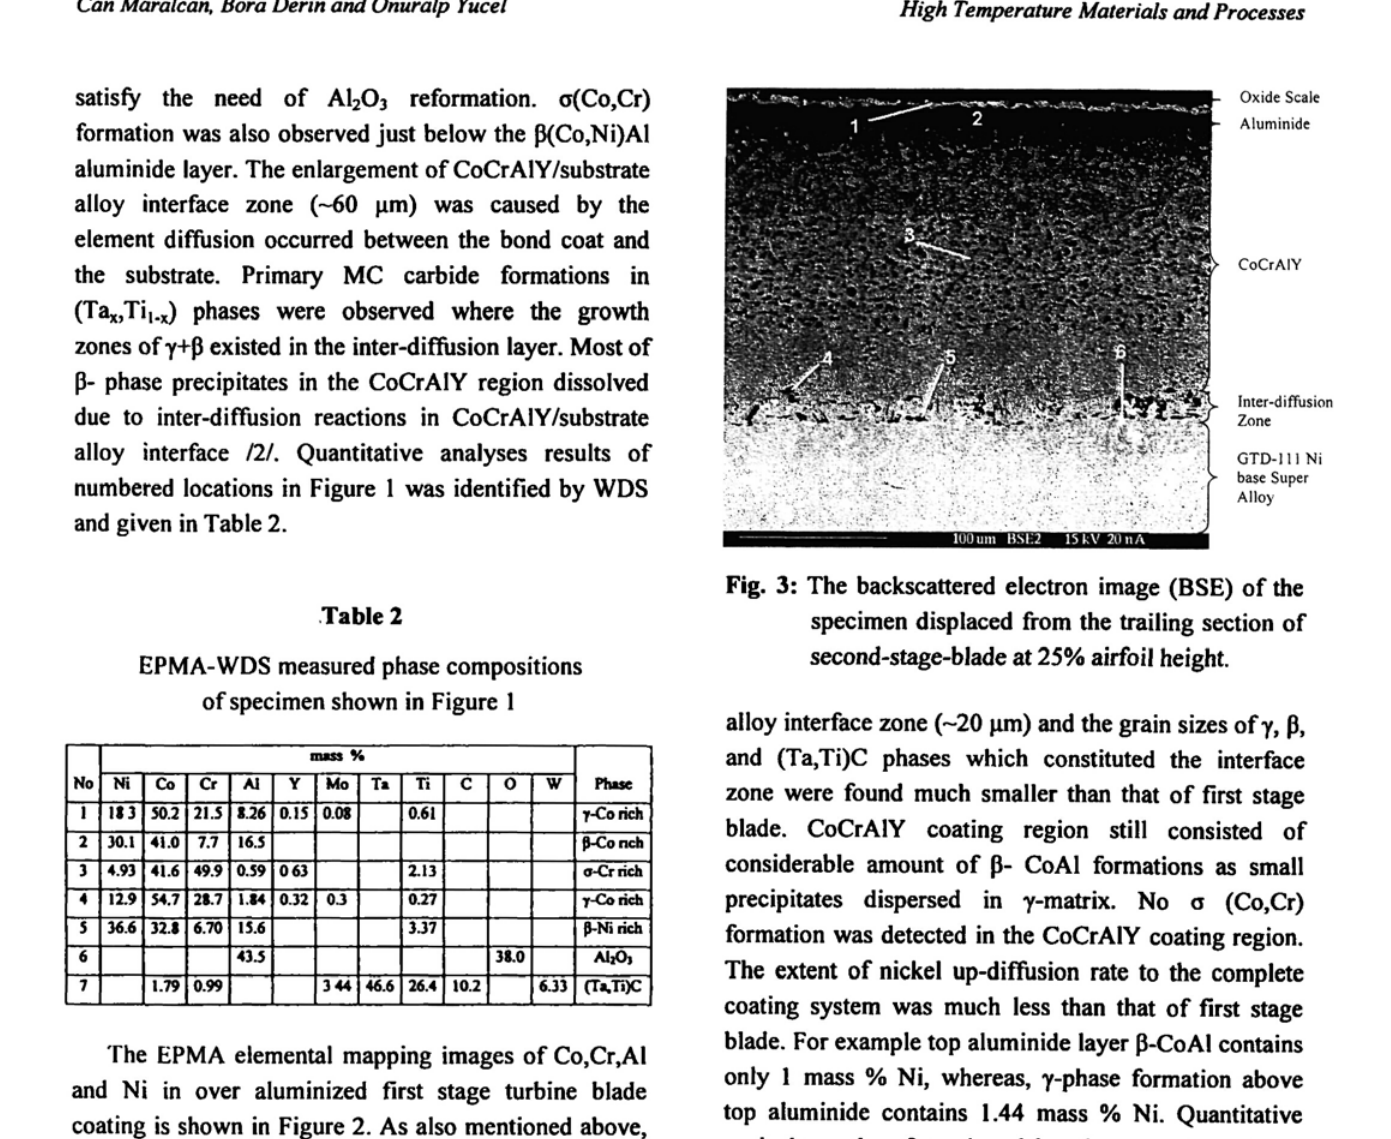
EPMA-WOS measured phase compositions of specimen shown in Figure